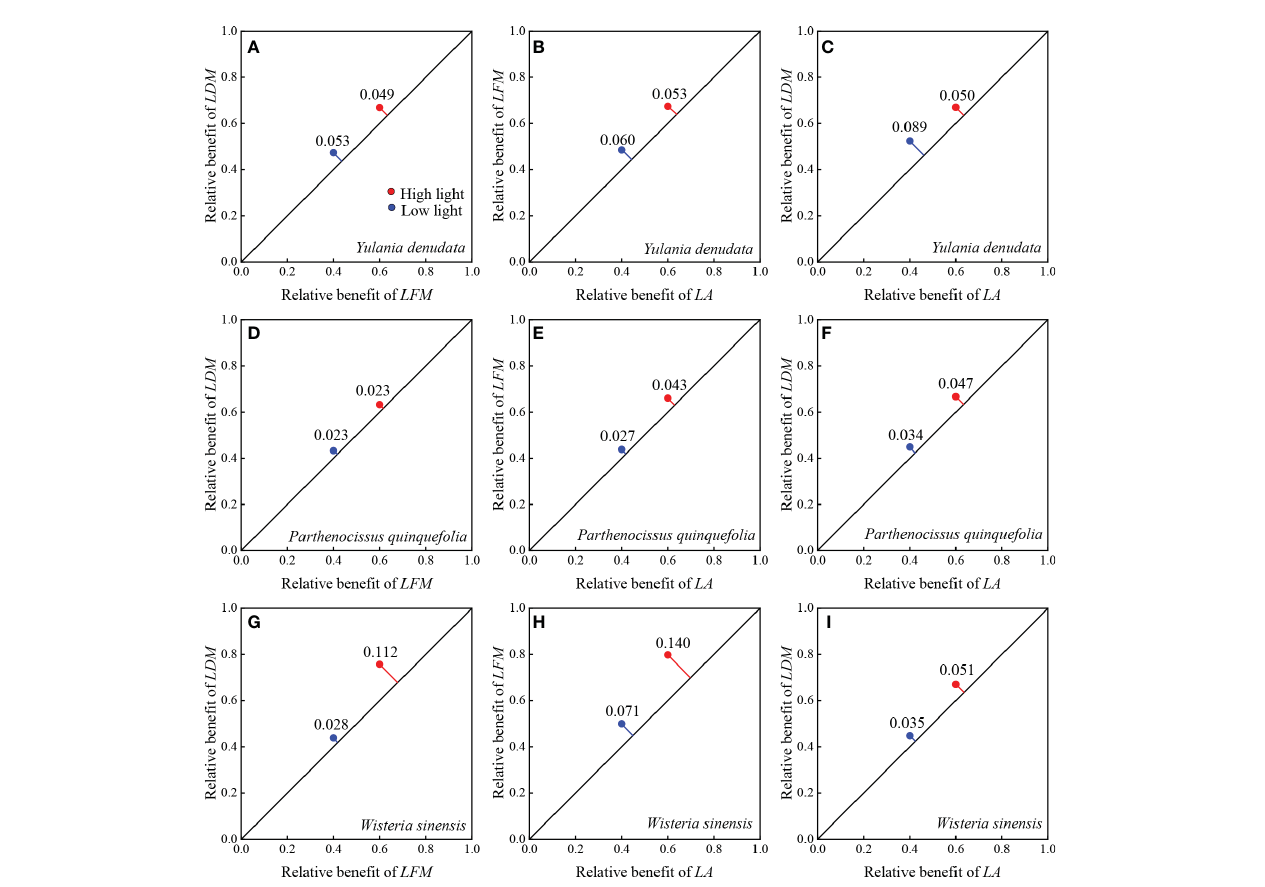
FIGURE 2 Relative bene fi ts between paired leaf traits of different urban plant. (A – C) represent the relative bene fi t between LDM with LFM , LFM with LA , and LDM with LA of Y. denudata leaves, respectively. (D – F) represent the relative bene fi t between LDM with LFM , LFM with LA , and LDM with LA of P. quinquefolia leaves, respectively. (G – I) represent the relative bene fi t between LDM with LFM , LFM with LA , and LDM with LA of W. sinensis leaves, respectively. The blue and red points indicate low light and high light habitats, respectively. The relative bene fi t is represented by the RMSE of paired traits. The RMSE represents the distance from the coordinate of the paired traits to the diagonal 1:1 line where the trade-off is zero. The farther the distance, the larger the relative bene fi